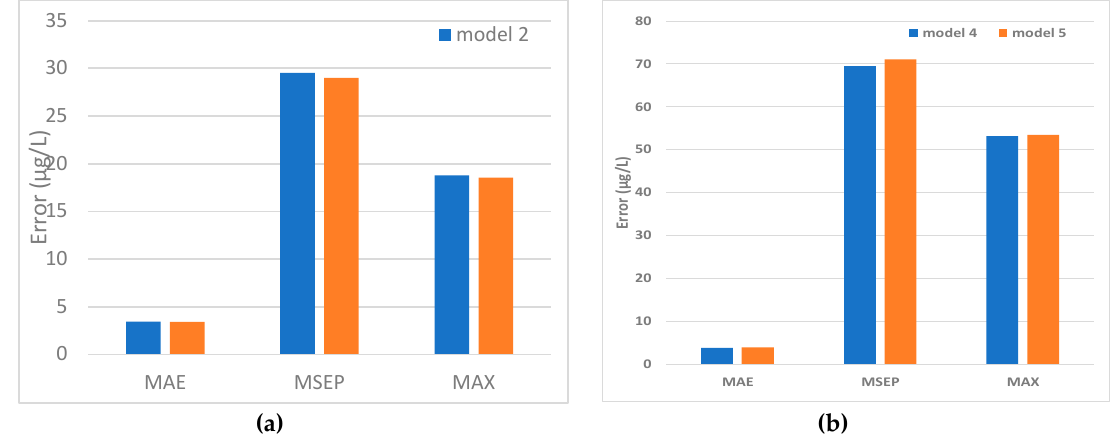
Figure 7. Error indicators for ( a ) models (2) and (3); ( b ) models (4) and (5).